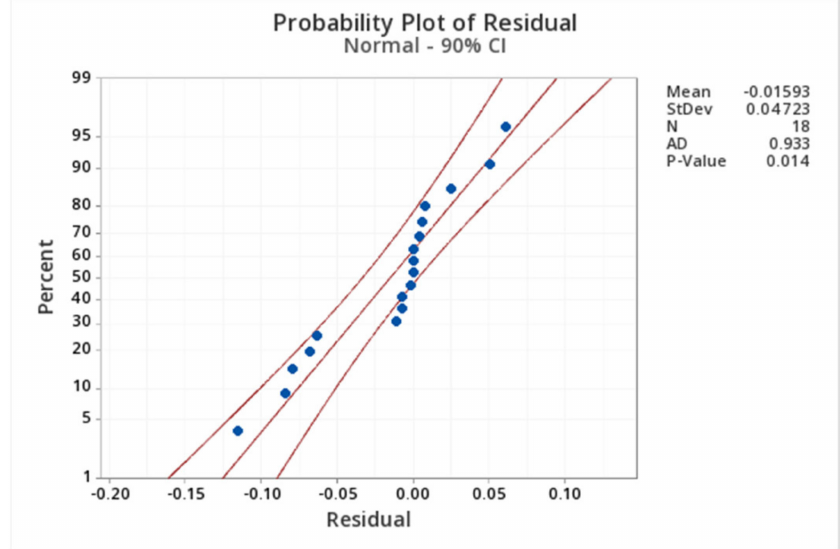
Figure A8. Residual normal probability plot for the acetol hydrogenation kinetic parameters estima-